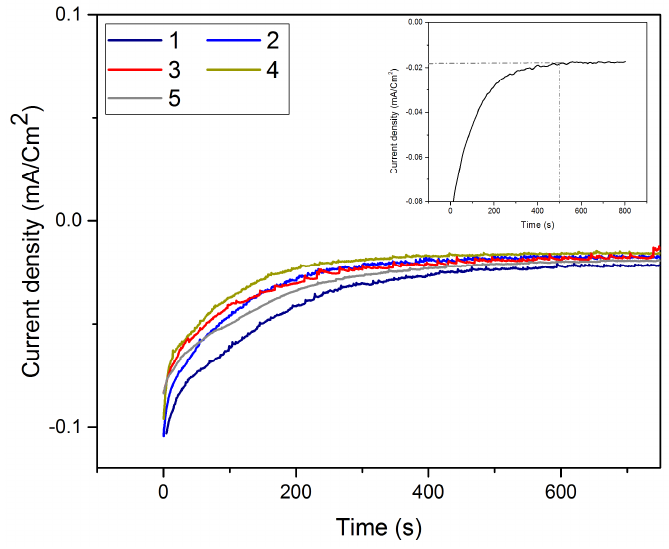
Figure 6. I-t curves recorded at OCV during the Pt replacement of Te layer for various numbers of replacements.